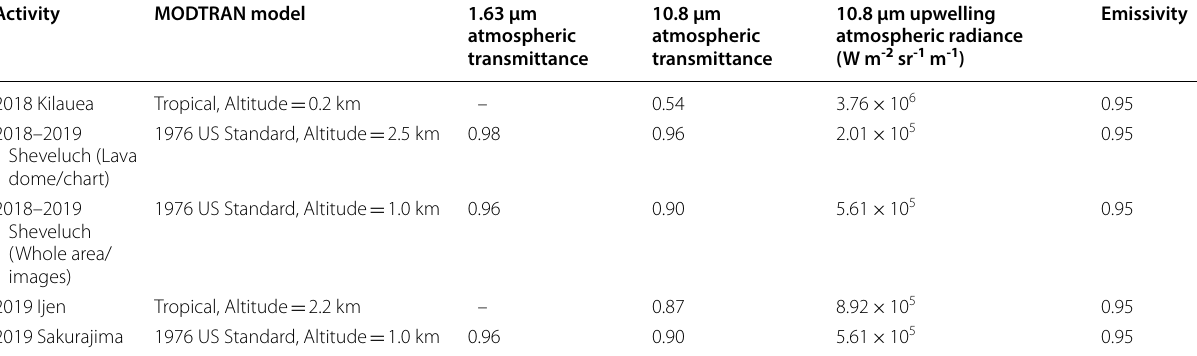
Table 2 Models and coefficients for the atmospheric correction and emissivity used in each study